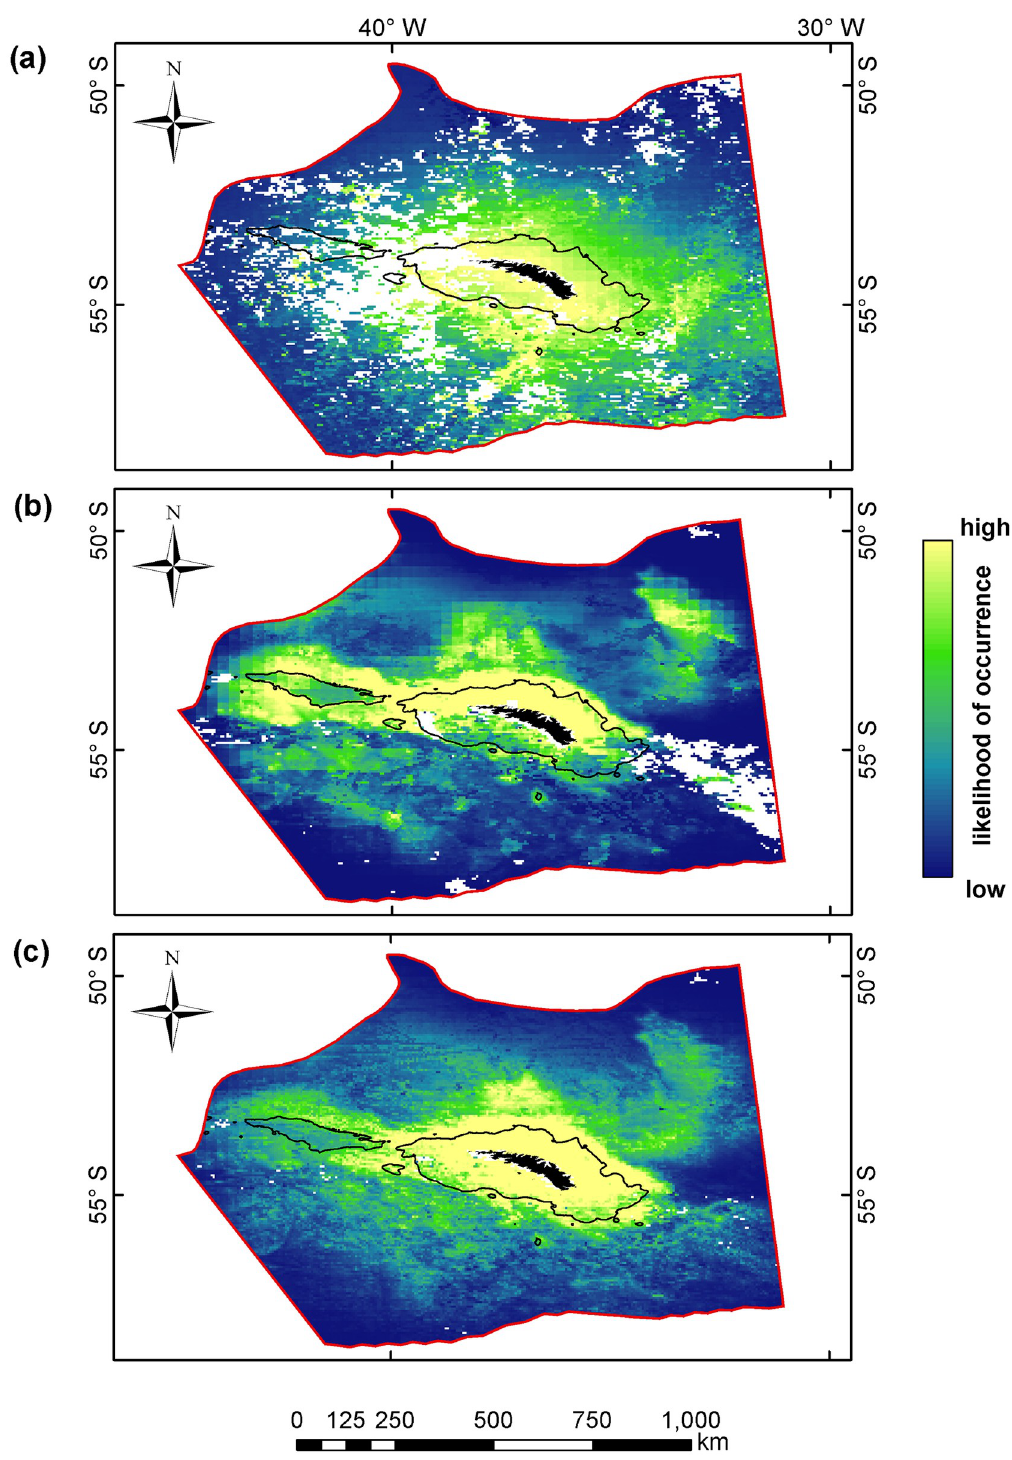
Fig 4. Spatial predictions of the GAM models for (a) winter of 1999 (May to August); (b) winter of 2003 (May to September); and (c) combined winter of both years (May to September). Red line denotes the boundary of the modelled area, bounded by the Polar Front to the north and the average position of the maximum winter ice extent between 1981–2010 to the south. Black line denotes the 1,000m bathymetric contour, which indicates the shelf-break of South Georgia. Blank cells indicate areas where there were gaps in the remotely sensed covariate data, and thus no prediction in these areas.